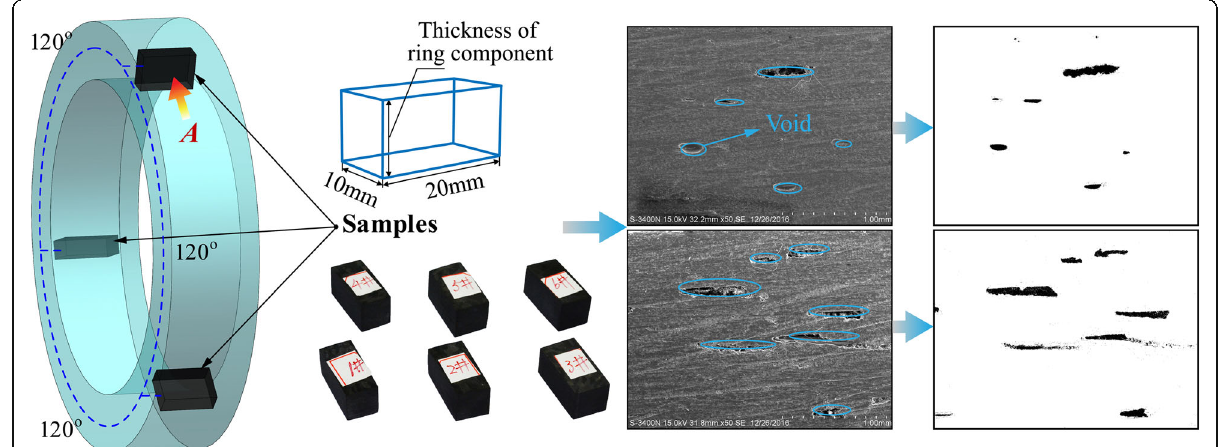
Fig. 4 Process of measuring void content for composite tape winding products